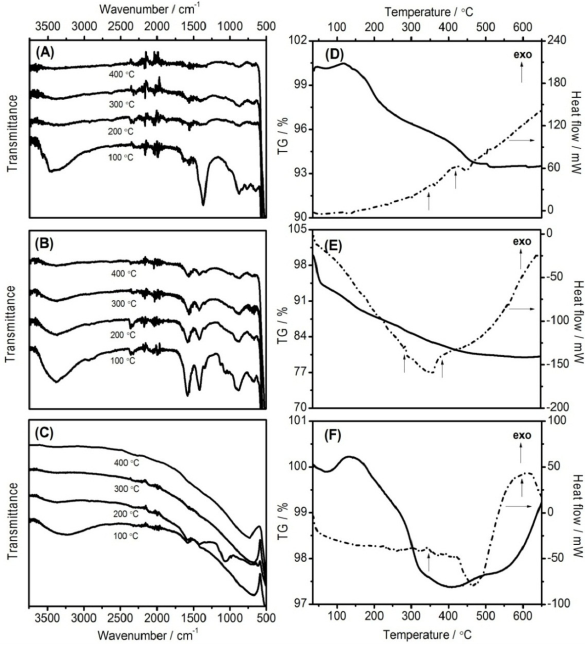
Figure 3: FTIR spectra of (A) ZnO NFs, (B) ZnO SPs, and (C) ZnO NRs at different annealing temperatures. Thermal decomposition (solid) and heat flow (dashed) curves of (D) ZnO NFs, (E) ZnO SPs, and (F) ZnO NRs. The arrows indicate exothermal peaks of the thermal